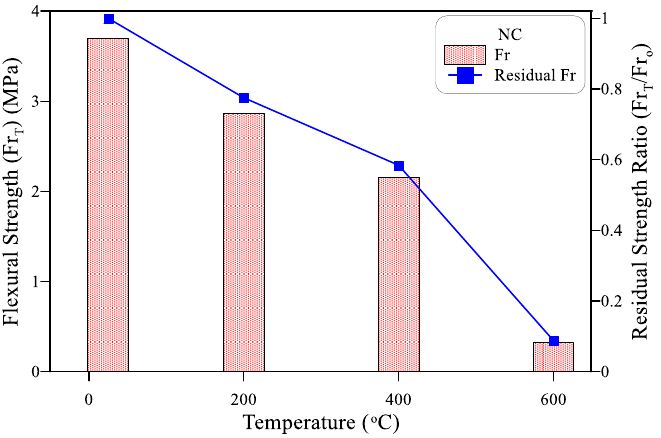
Figure 6. Residual flexural strength of NC at different temperatures.